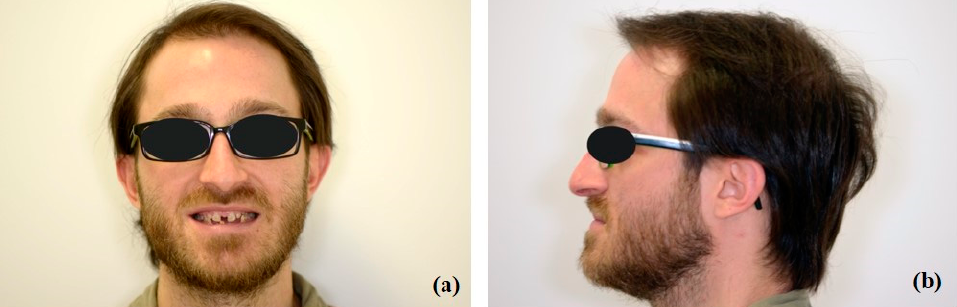
Figure 1. Extraoral examination: ( a ) front view; ( b ) side view.